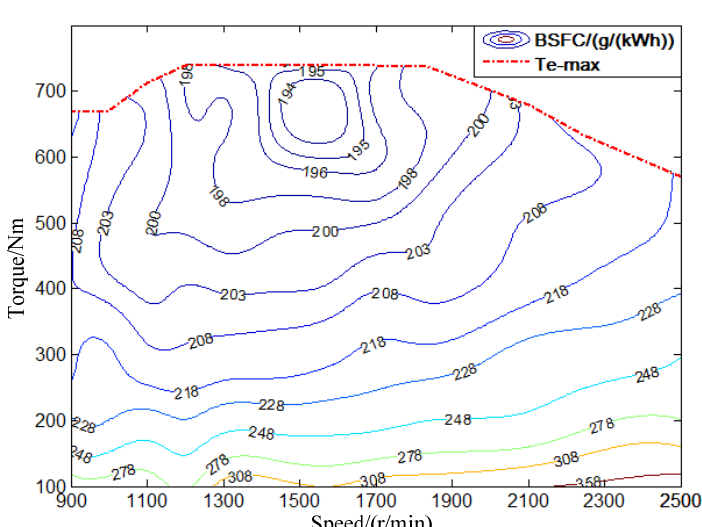
Figure 4. The ICE fuel consumption